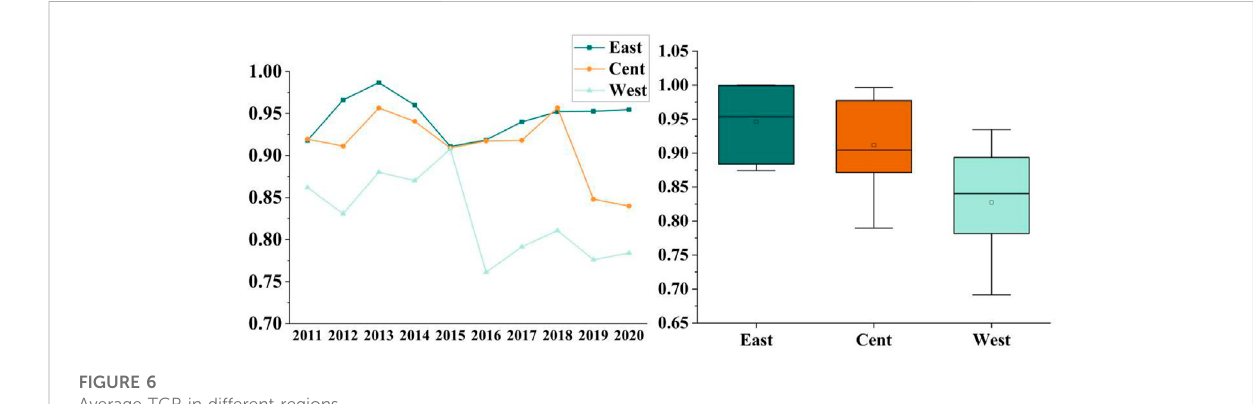
FIGURE 6 Average TGR in different